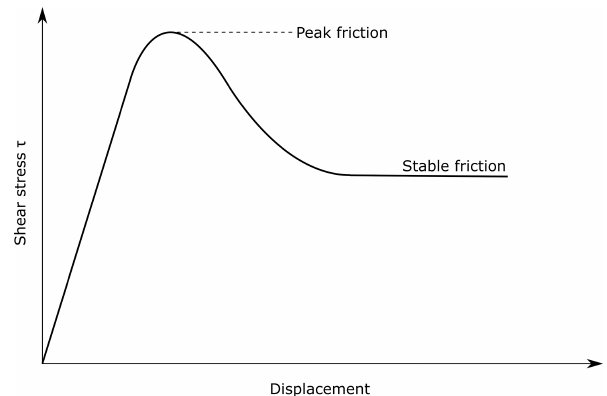
Figure 3. Ideal output from a shear test. The peak friction corre- sponds to the high point of the curve, while stable friction is defined by the subsequent